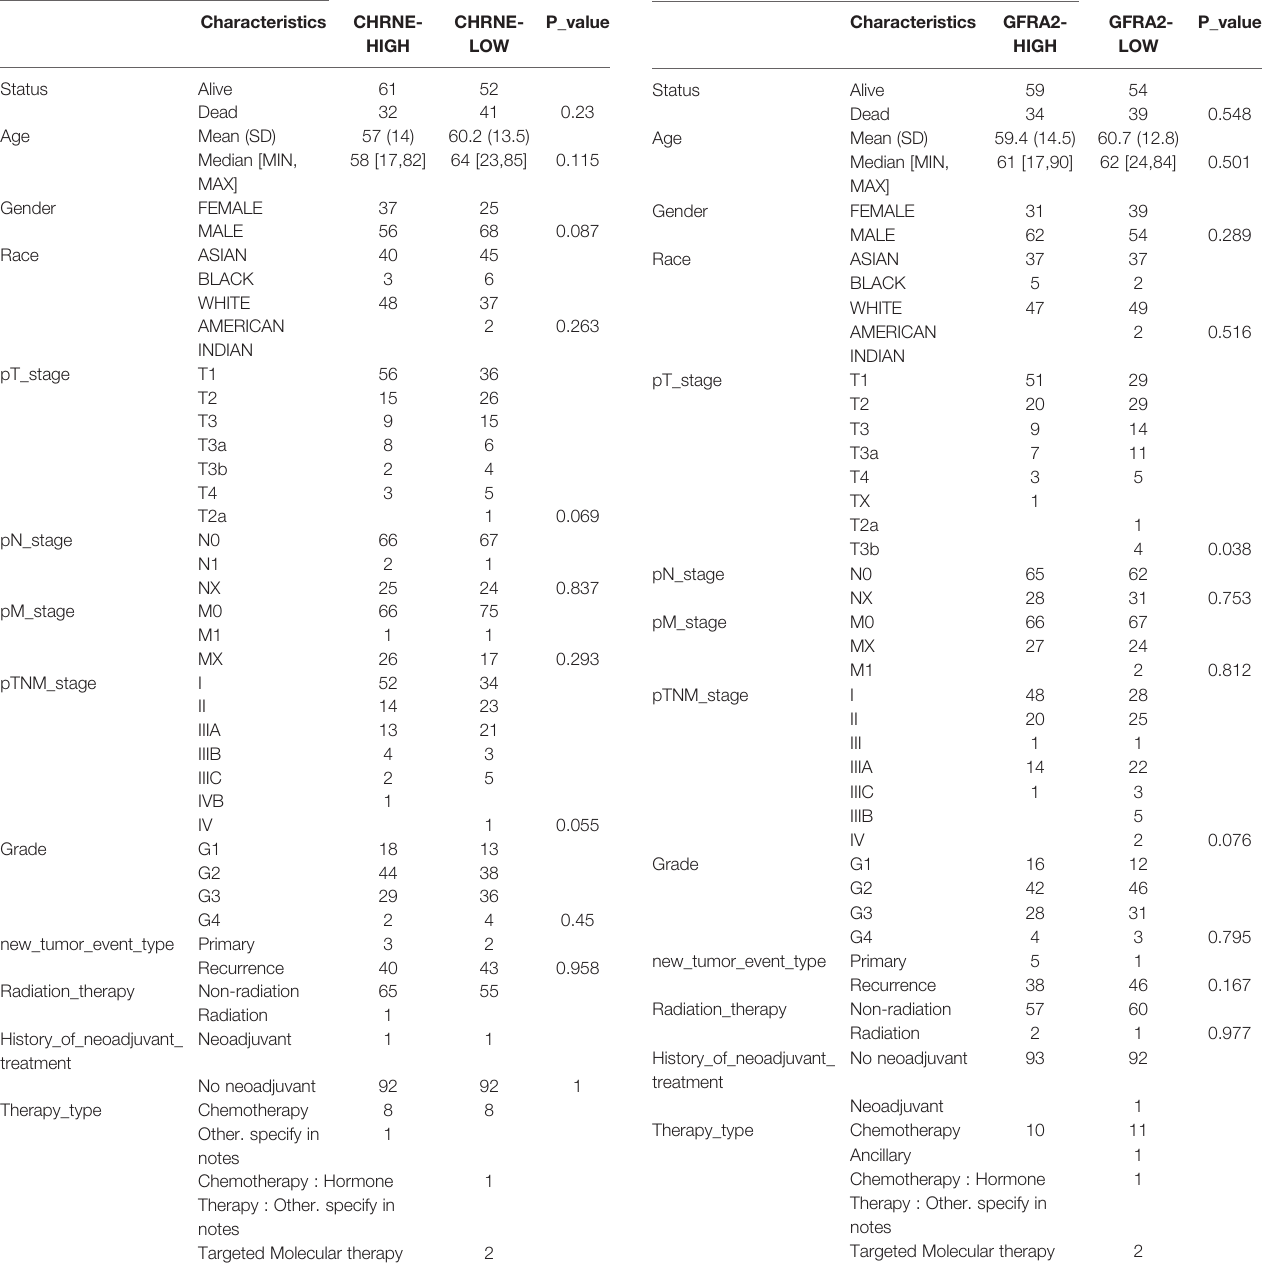
TABLE 3 | Comparisons of clinical characteristics between high and low GFRA2 expression groups. GFRA2-HIGH vs